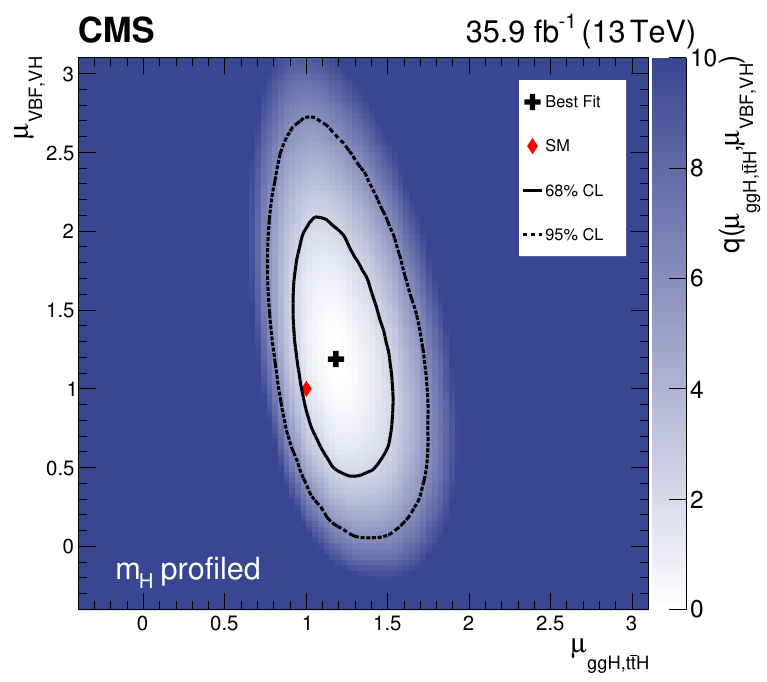
Figure 19 . The two-dimensional best (cid:12)t (black cross) of the signal strength modi(cid:12)ers for fermionic (ggH, ttH) and bosonic (VBF, ZH, WH) production modes compared to the SM expectation (red diamond). The Higgs boson mass is pro(cid:12)led in the (cid:12)t. The solid (dashed) line represents the 68 (95)% con(cid:12)dence